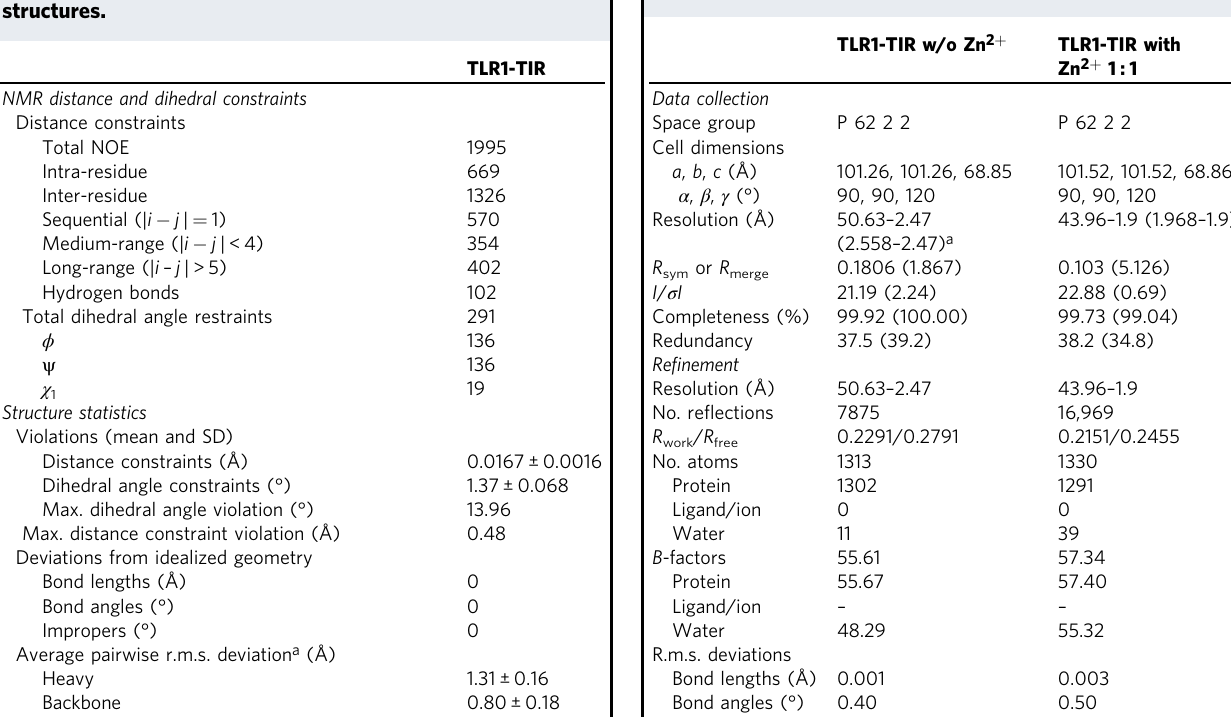
Table 2 Data collection and re fi nement statistics (molecular